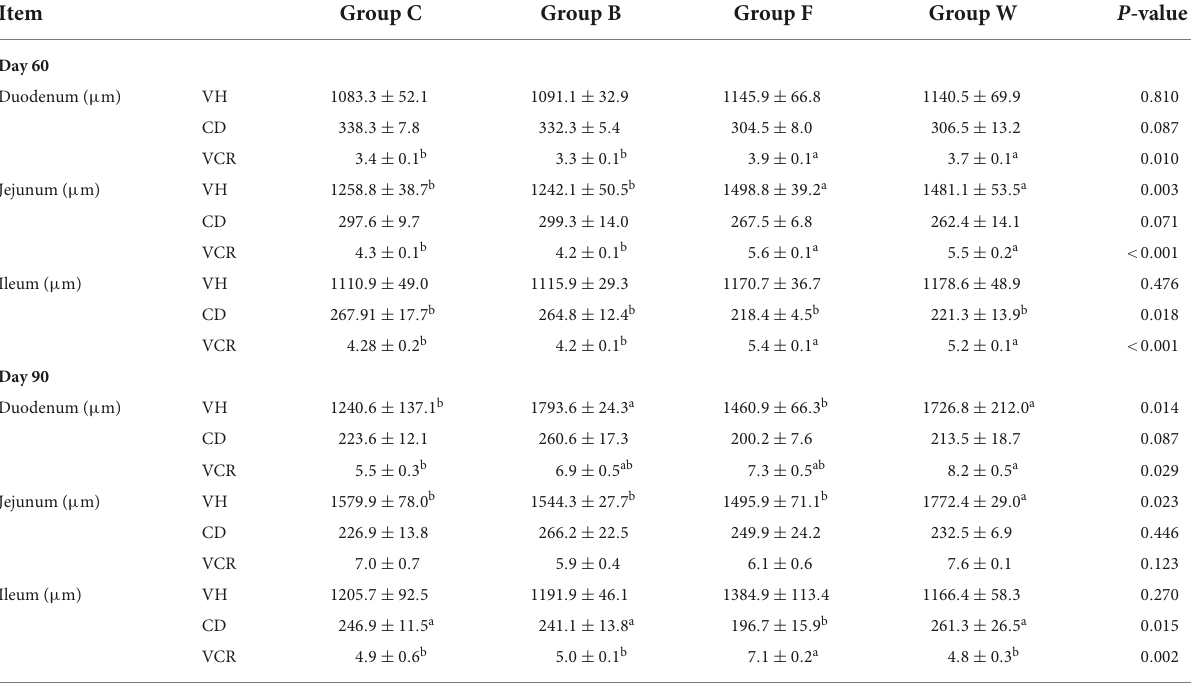
TABLE 4 Effects of brewers’ spent grain (BSG) on the intestinal morphology of the four groups of Landes geese (i.e., groups C, B, F, and W) in 60 and 90 days. Item Group C Group B